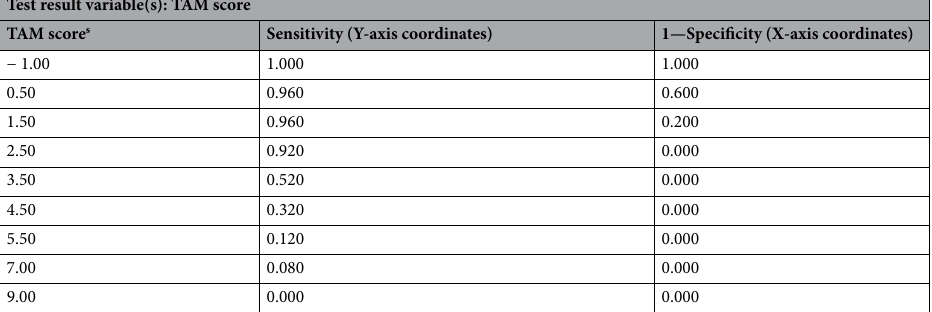
Table 2. Sensitivity and 1-specificity values at different AMS, calculated based on the ROC curve (Coordinates of the curve) in B-S kinship analysis by autosomal STR. The smallest TAM cutoff score value is the minimum observed test value minus 1, and the most considerable cutoff value is the maximum perceived test value plus 1. All the other cutoff values are the averages of two consecutive ordered observed test